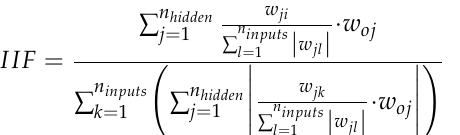
Figure 27. Comparison between prediction values and test values of RAC compressive strength (all data).